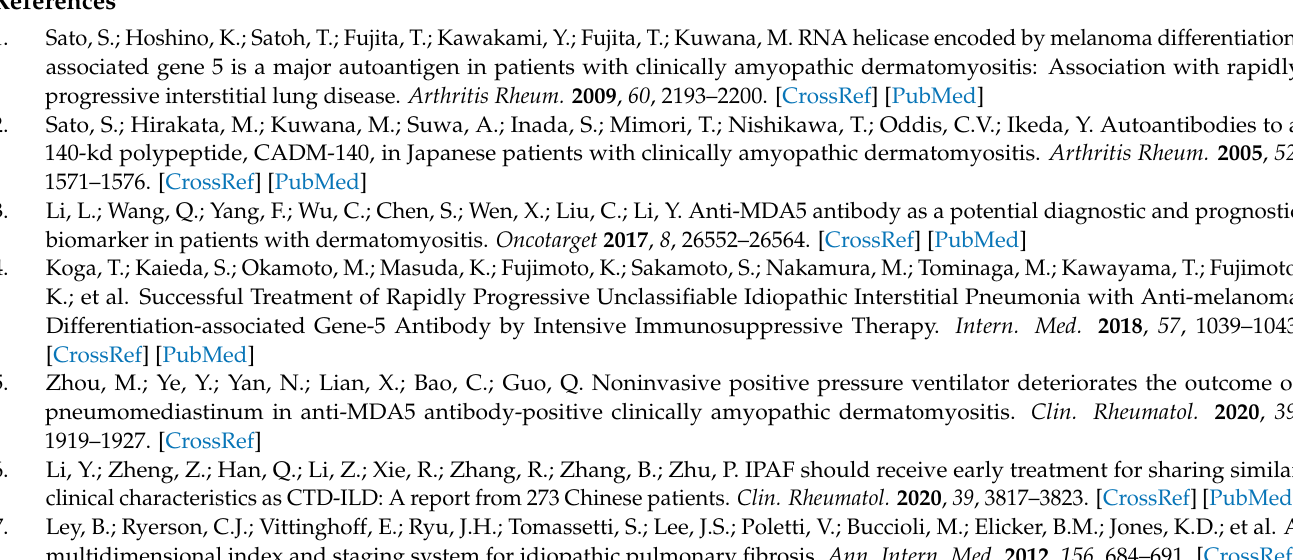
Table S1: Components of the GAP score. Table S2: Cut-off levels of significant variables associated with 1-year mortality determined by ROC